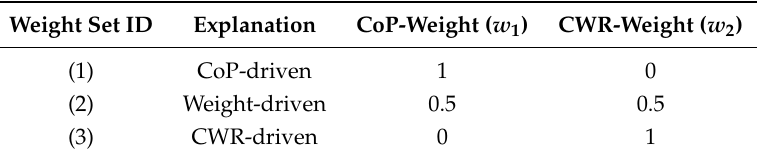
Table 2. Multi-objective weights.